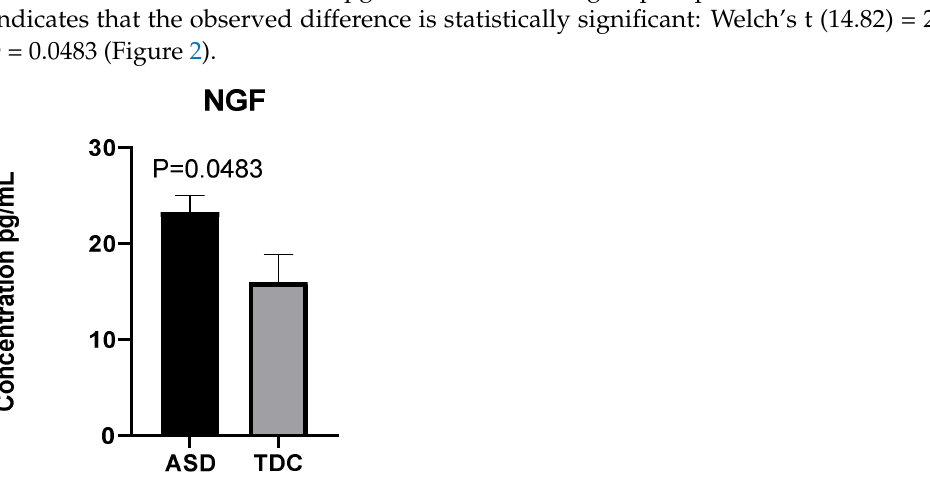
Figure 2. Elevated plasma NGF in children with ASD ( n = 40) compared to typically developing children (TDC) ( n =